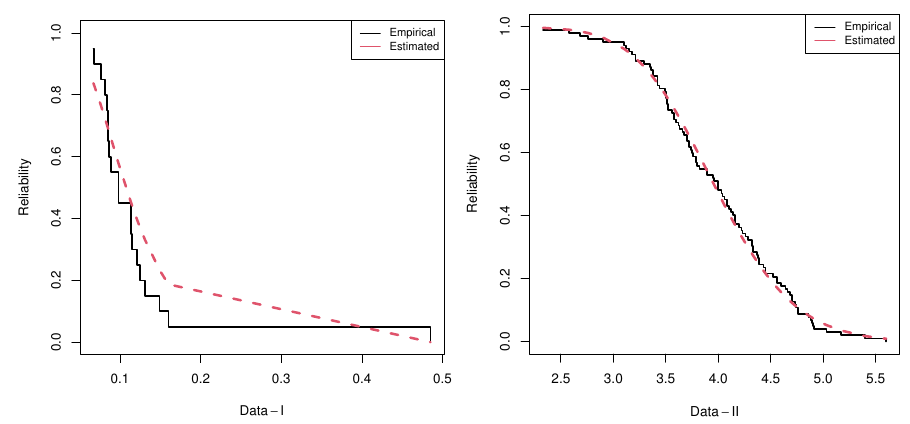
Figure 8. Plot of estimated/empirical RF of the APW distribution under real data sets.